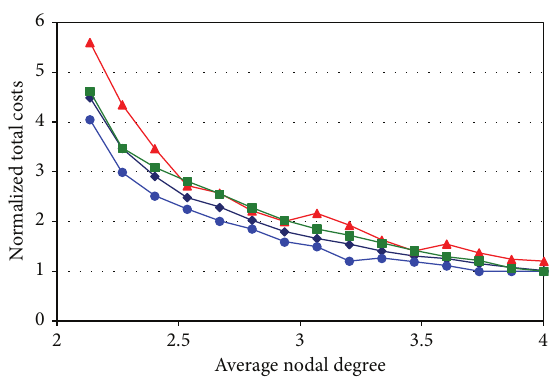
Figure 7: Normalized 1+1 APS JCA total capacity costs.